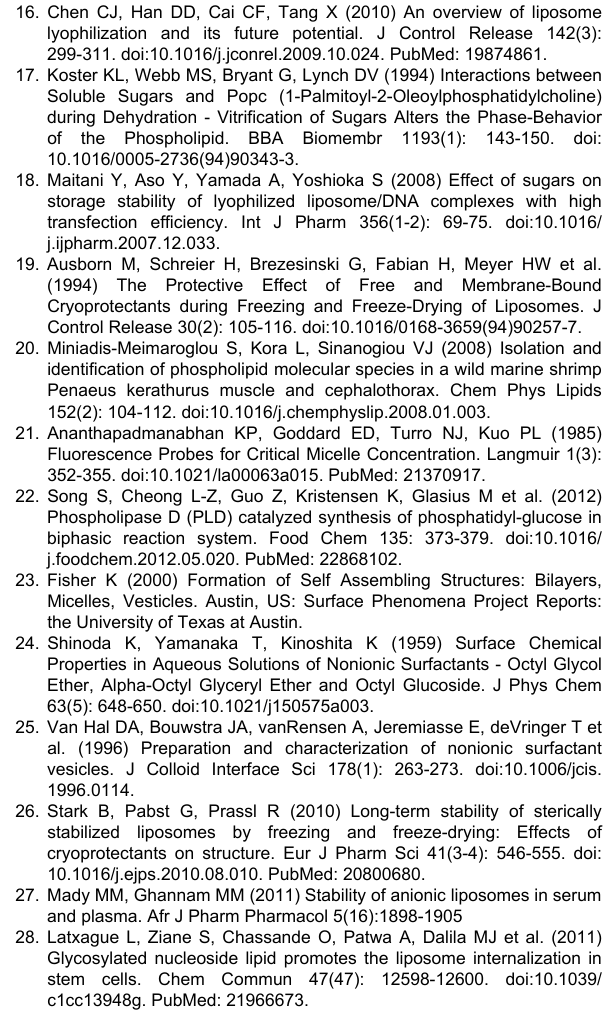
Figure S2. Structural elucidation of Ptd-Suc. ( A ) Base-peak and extracted ion chromatograms and full FTMS spectrum of Ptd-Suc. ( B ) MS 2 spectra of the two major isomers.